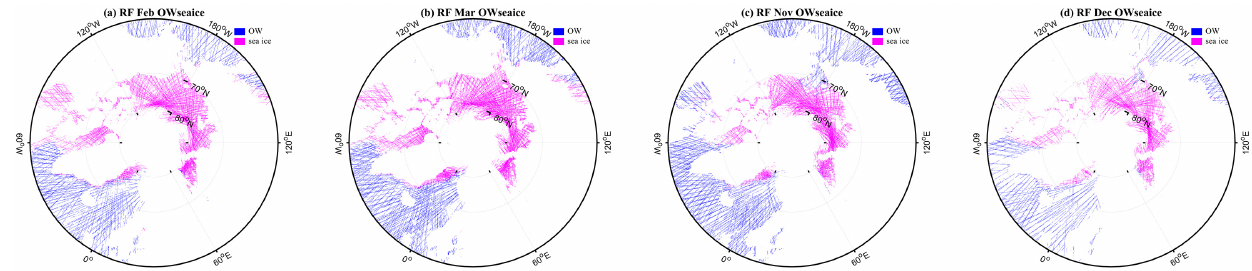
Figure A3. RF for OW-sea ice classification using the data in April as the training set. The data in ( a ) February, ( b ) March,